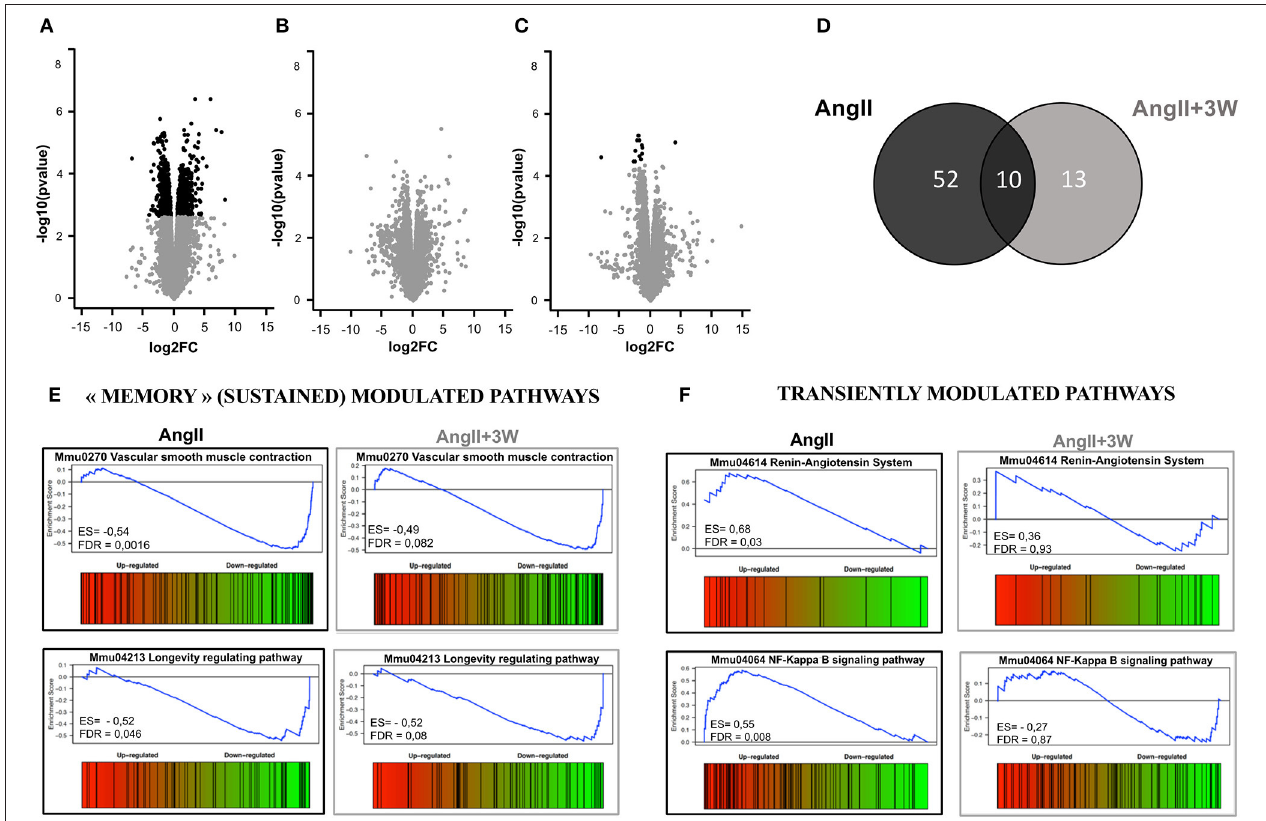
FIGURE 3 | Transcriptomic profiling of aortic tissue from AngII memory model. Volcano plot representing the analysis of differential expression of genes in (A) AngII vs. CTRL ; (B) AngII + 2W vs. CTRL and (C) AngII + 3W vs. CTRL data sets. Black points mark the genes with significantly (FDR < 0.05) increased or decreased expression compared to CTRL. The x-axis shows log 2 fold-changes in expression and the y-axis the –log 10 ( p -value). (D) Gene set enrichment analysis (GSEA) from compiled KEGG pathways. Venn diagram showing the number of gene sets differentially modulated in each condition, and the overlap for 10 of them (FDR value < 0.1) (E) Enrichment score diagram illustrating the expression pattern of 2 of the 10 commonly regulated pathways (e.g., present in AngII and in AngII + 3w , and modulated in the same direction) “vascular smooth muscle contraction” and “longevity regulating pathway”. (F) Enrichment score diagram illustrating the expression pattern of 2 transiently modulated pathways by Angiotensin II infusion: “Renin angiotensin System” and “NF KappaB signaling pathway”.